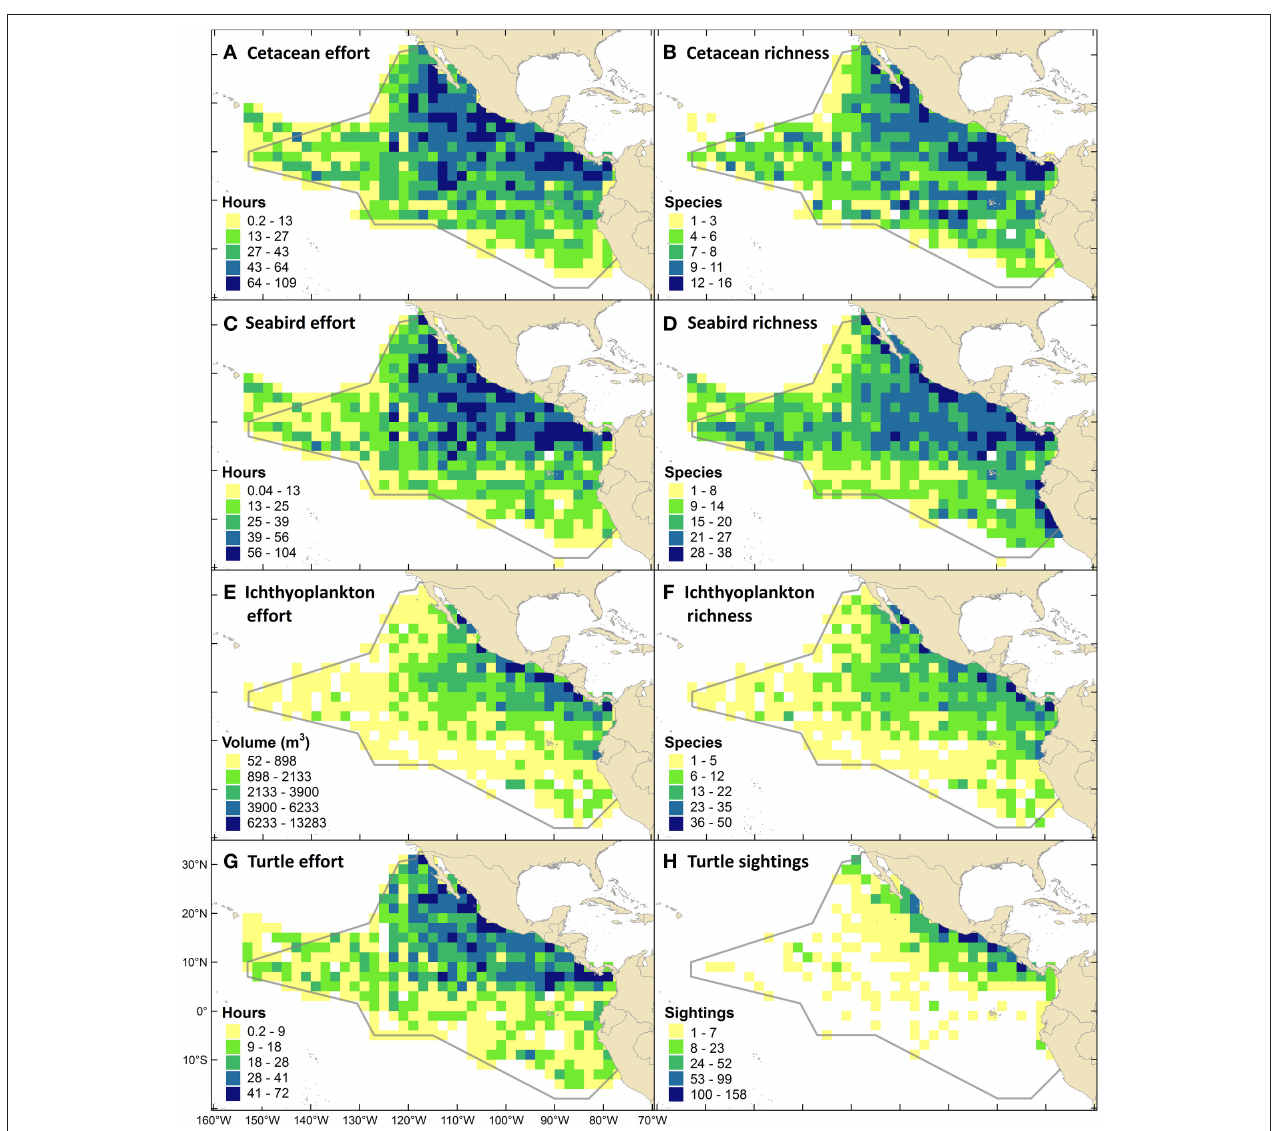
FIGURE 5 | Survey effort, species richness, and sightings density maps using data from Southwest Fisheries Science Center (NOAA Fisheries) ship-based surveys conducted from August through November in 1986-1990, 1998-2000, 2003, 2006. (A) Cetacean line-transect survey effort (all 10